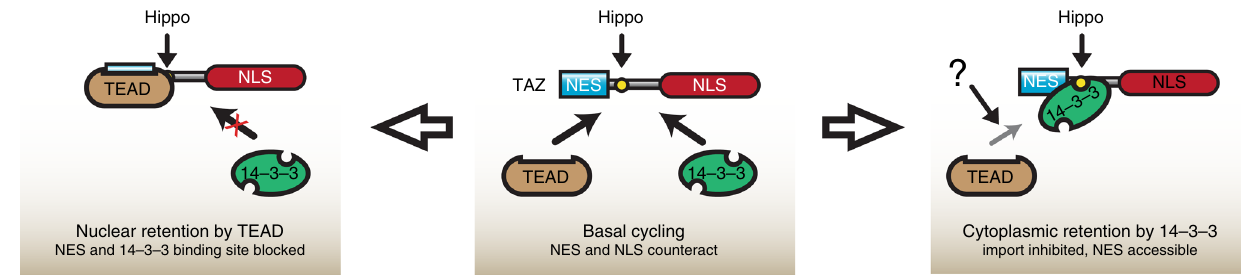
Fig. 9 Model for NES masking- and competition-mediated regulation of nuclear export. 14 – 3 – 3 and TEAD recognition sites in the N-terminus of TAZ are in close proximity. Binding of TEAD blocks the function of the NES and might limit access of 14 – 3 – 3, thereby switching off export (left). Various regulatory inputs impeding TEAD – TAZ interaction are indicated by “ question mark ” (see Discussion); the NES remains accessible, leading to nuclear exit (right). The input of the Hippo pathway (on S89 phosphorylation) is